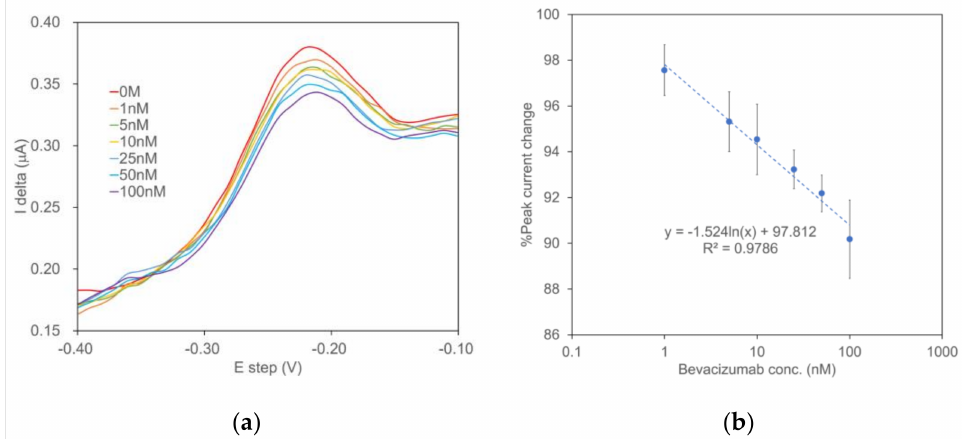
Figure 4. ( a ) Square − wave voltammograms of fabricated PES-bivalent A14#1 aptamer immobi- lized sensor at 100Hz in 10-fold diluted artificial serum solution. SWV scans were conducted according to the following conditions: − 0.4 to − 0.1 V, 25 mV amplitude. Seven concentrations of bevacizumab were used: 0 nM (the base line in the absence of bevacizumab), 1, 5, 10, 25, 50, and 100 nM. ( b ) Concentration-response curve; the % of signal change calculated as 0M = 0%. The error bars indicate the standard deviations ( n =